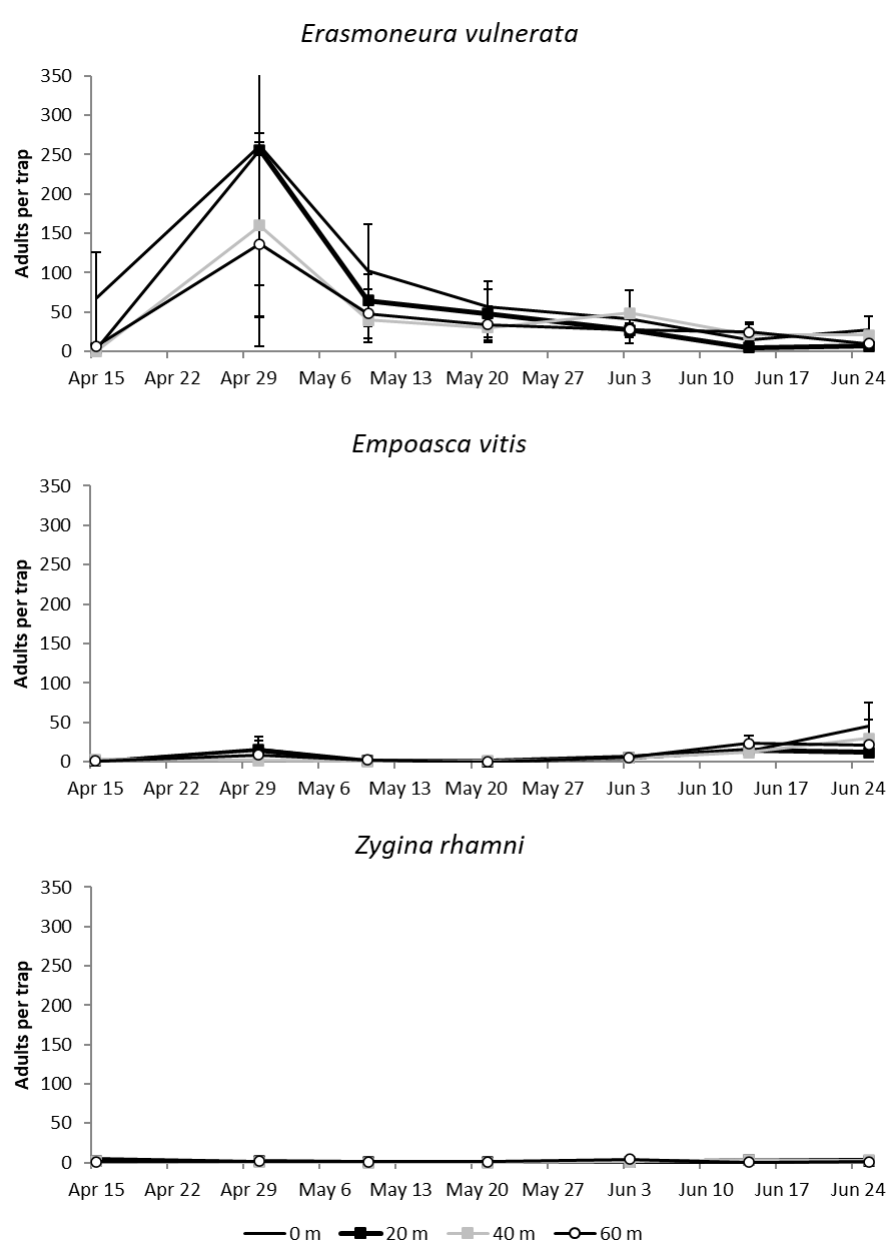
Figure 4. Mean ( ± std. err.) number of adult E. vulnerata , E. vitis and Z. rhamni catches on traps placed at increasing distances from the vineyard margins in the spring of 2019.